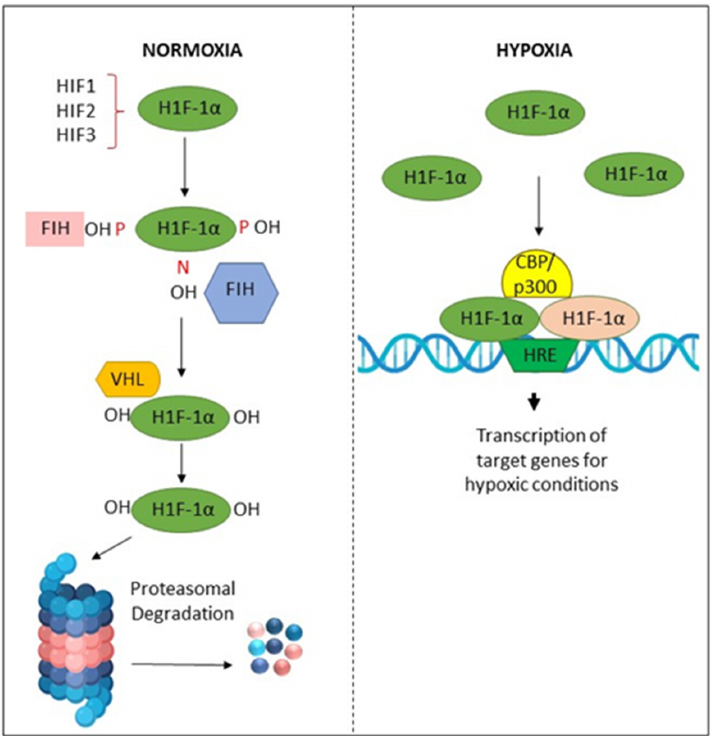
Figure 5. Activation and degradation of the hypoxia-inducible factor-1 α (HIF-1 α ). In normoxia, HIF-1 α is degraded rapidly, while in hypoxic conditions, it is accumulated. HIF-1 α associates with HIF-1 β , and the resulting heterodimer binds to the hypoxia response element (HRE) of target genes. The factor inhibiting HIF-1 (FIH-1) is a protein that binds to HIF-1 α and inhibits its transactivation function. The von Hippel–Lindau (VHL) protein is a tumor suppressor.